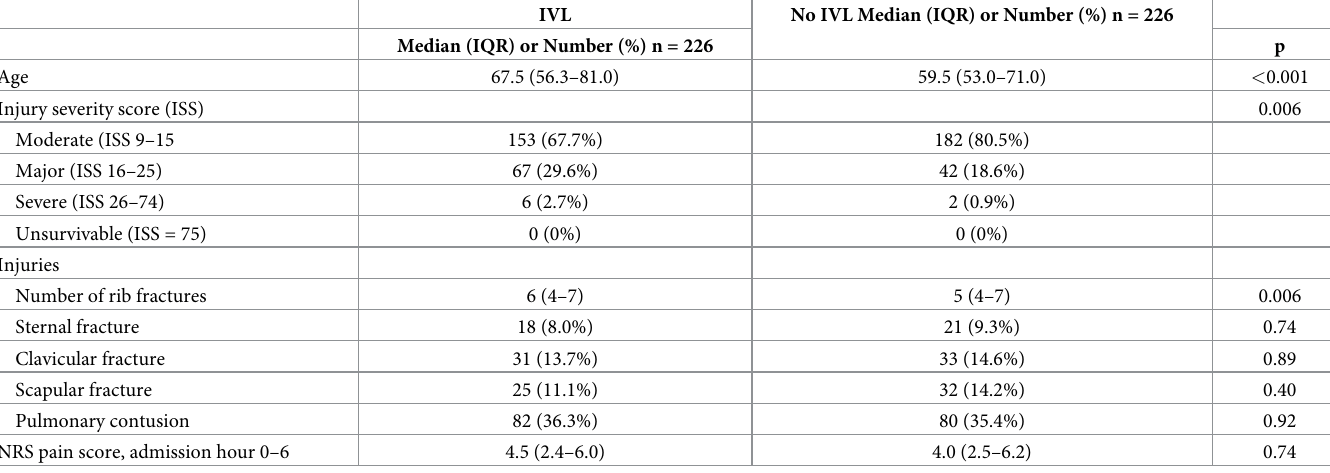
Table 2. Baseline characteristic comparison of propensity score-matched patients on vs not on IVL infusion.